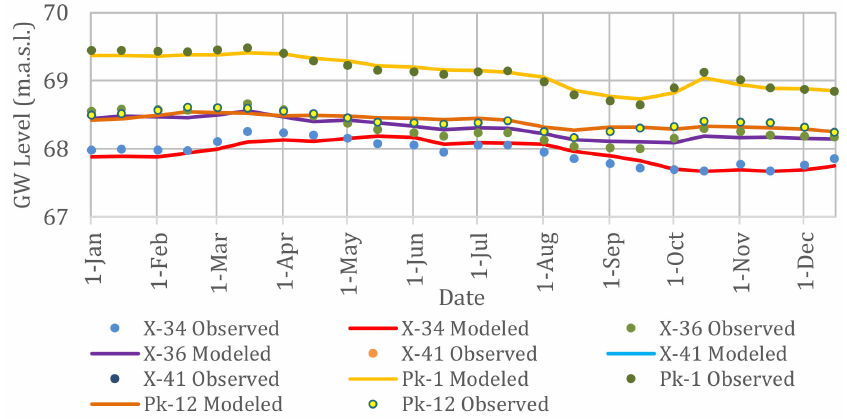
Figure 9. Observed and modeled groundwater levels at observation wells X-34, X-36, X-41, Pk-1 and Pk-12 (1 January to 31 December 2015).